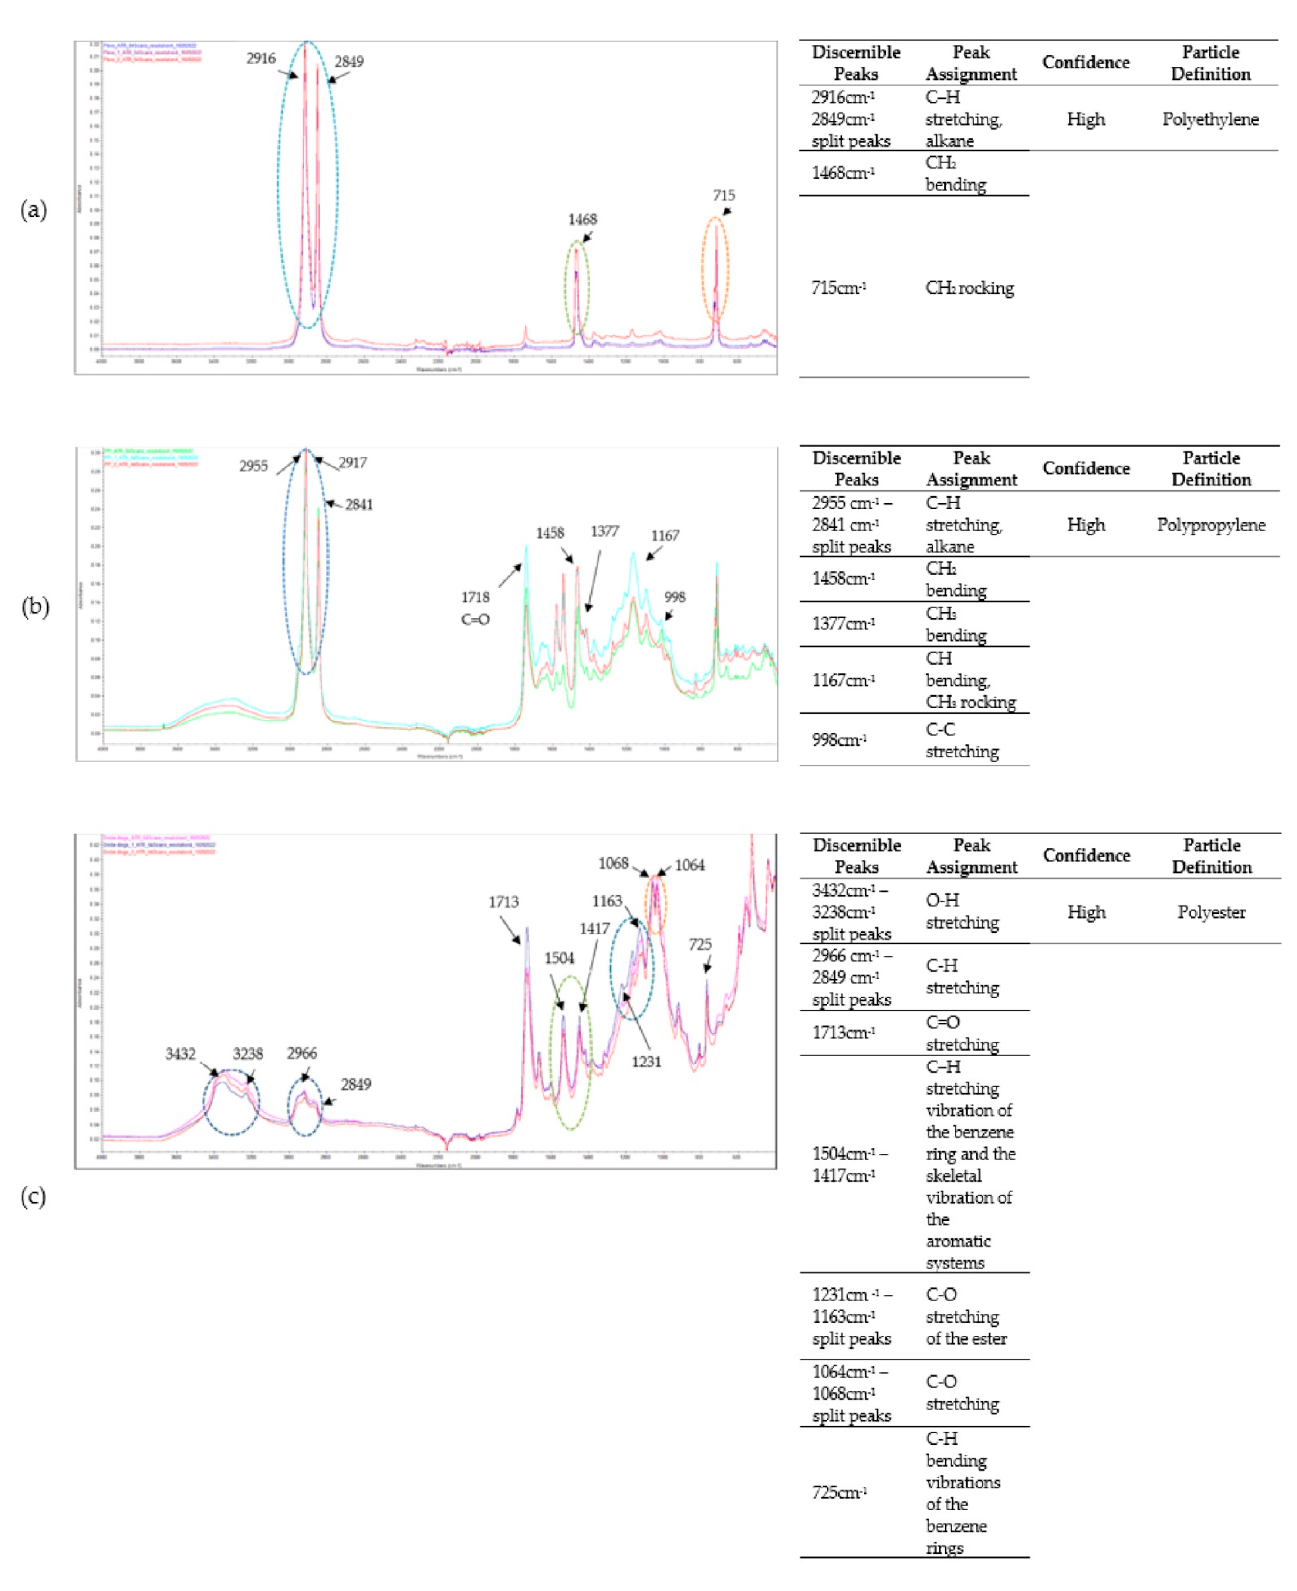
Figure 7. FT-IR-ATR spectra of the most common morphological types in ship sewage samples: polyethylene ( a ), polypropylene ( b ), and a polyester fibre ( c ).